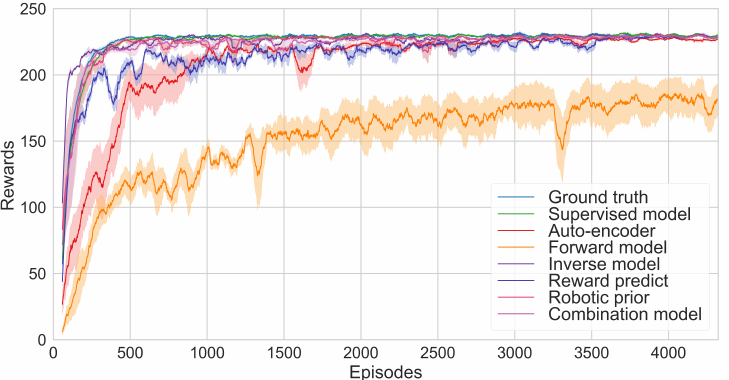
(a) RL performance based on DQN algorithm. Figure 11. Performance (mean and standard error for 5 runs) on mobile robot one-random-target task with PPO algorithm for different SRL